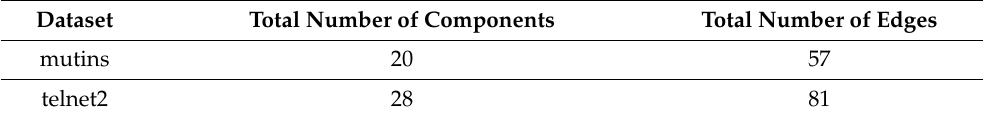
Table 5. Dataset information.